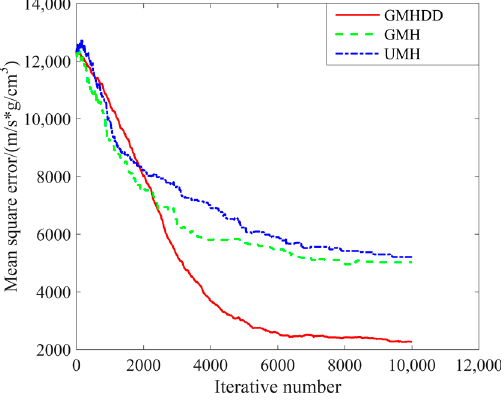
Figure 4. The relationship between the mean square error and iteration number from the three methods.